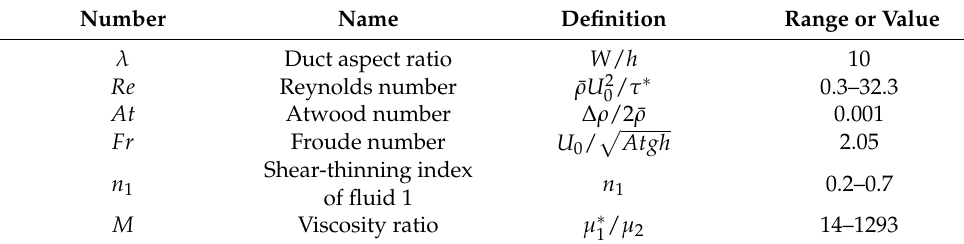
Table 2. Dimensionless number relevant for the current